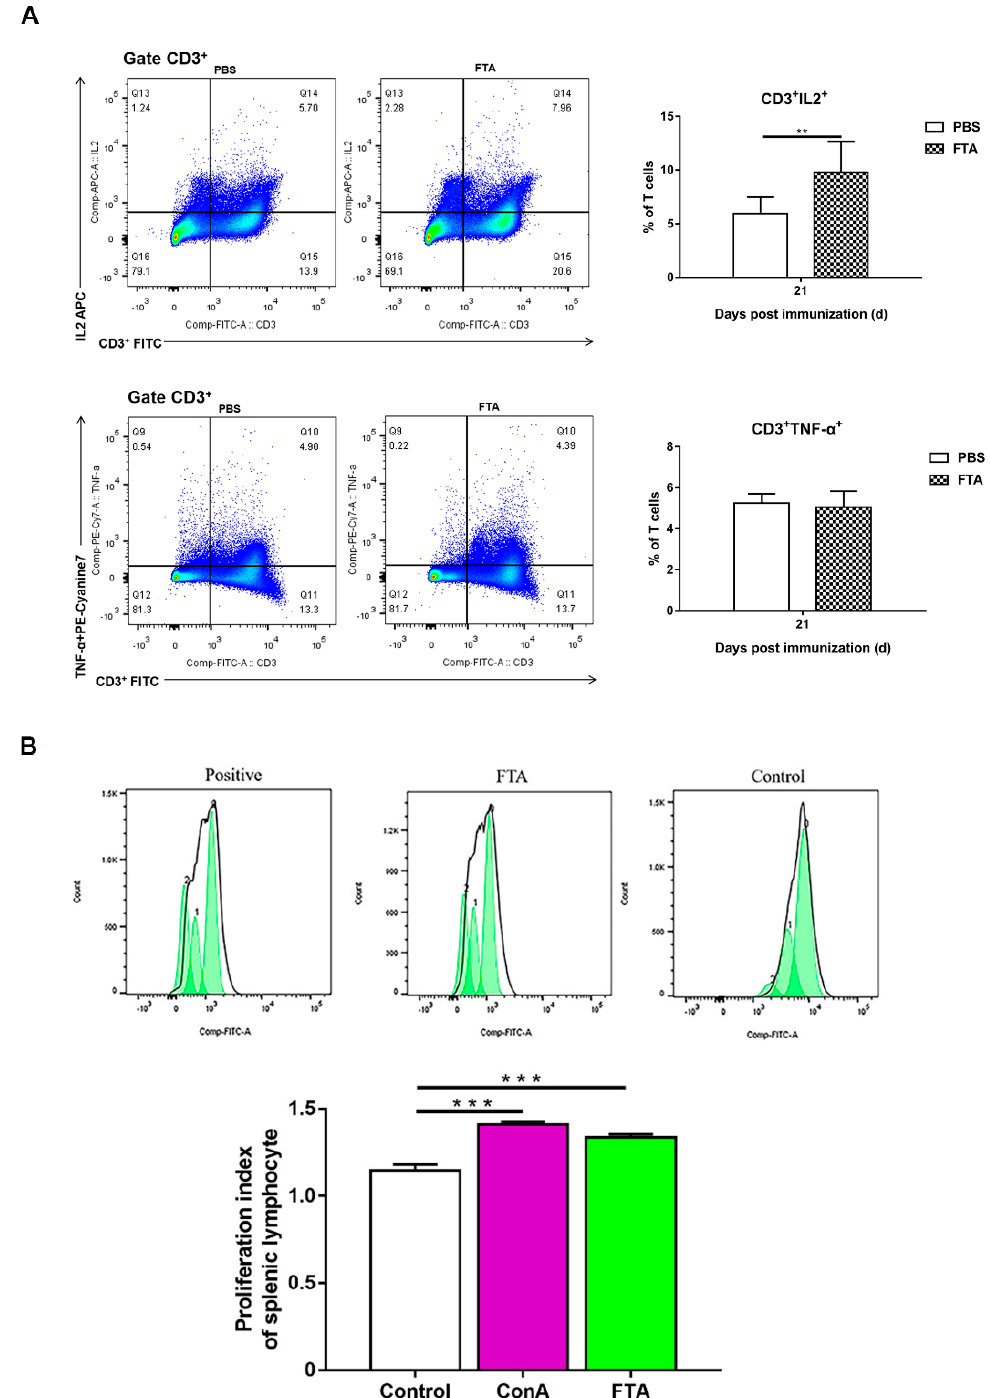
Figure 6. Analysis of peripheral blood lymphocytes CD3 + IL2 + and CD3 + TNF − α + T cells and splenic lymphocytes proliferation of the mice. ( A ) Flow cytometric analysis of the percentage of CD3 + IL2 + and CD3 + TNF − α + cells among CD3 + T cells. Left: representative flow cytometry dot plot shows the gating strategy for CD3 + IL2 + and CD3 + TNF − α + expression in peripheral CD3 + T cells. Right: The data are the mean percentage of CD3 + IL2 + and CD3 + TNF − α + T cells among CD3 + T cells ± SEM of three individual mice from each group detected in triplicate. ** p < 0.01. ( B ) Spleen lymphocyte proliferation of the mice treated with FTA. Left: histogram of splenic lymphocyte proliferation. Right: The data are the mean stimulation index ± SEM of three individual mice from each group detected in triplicate. *** p < 0.001.